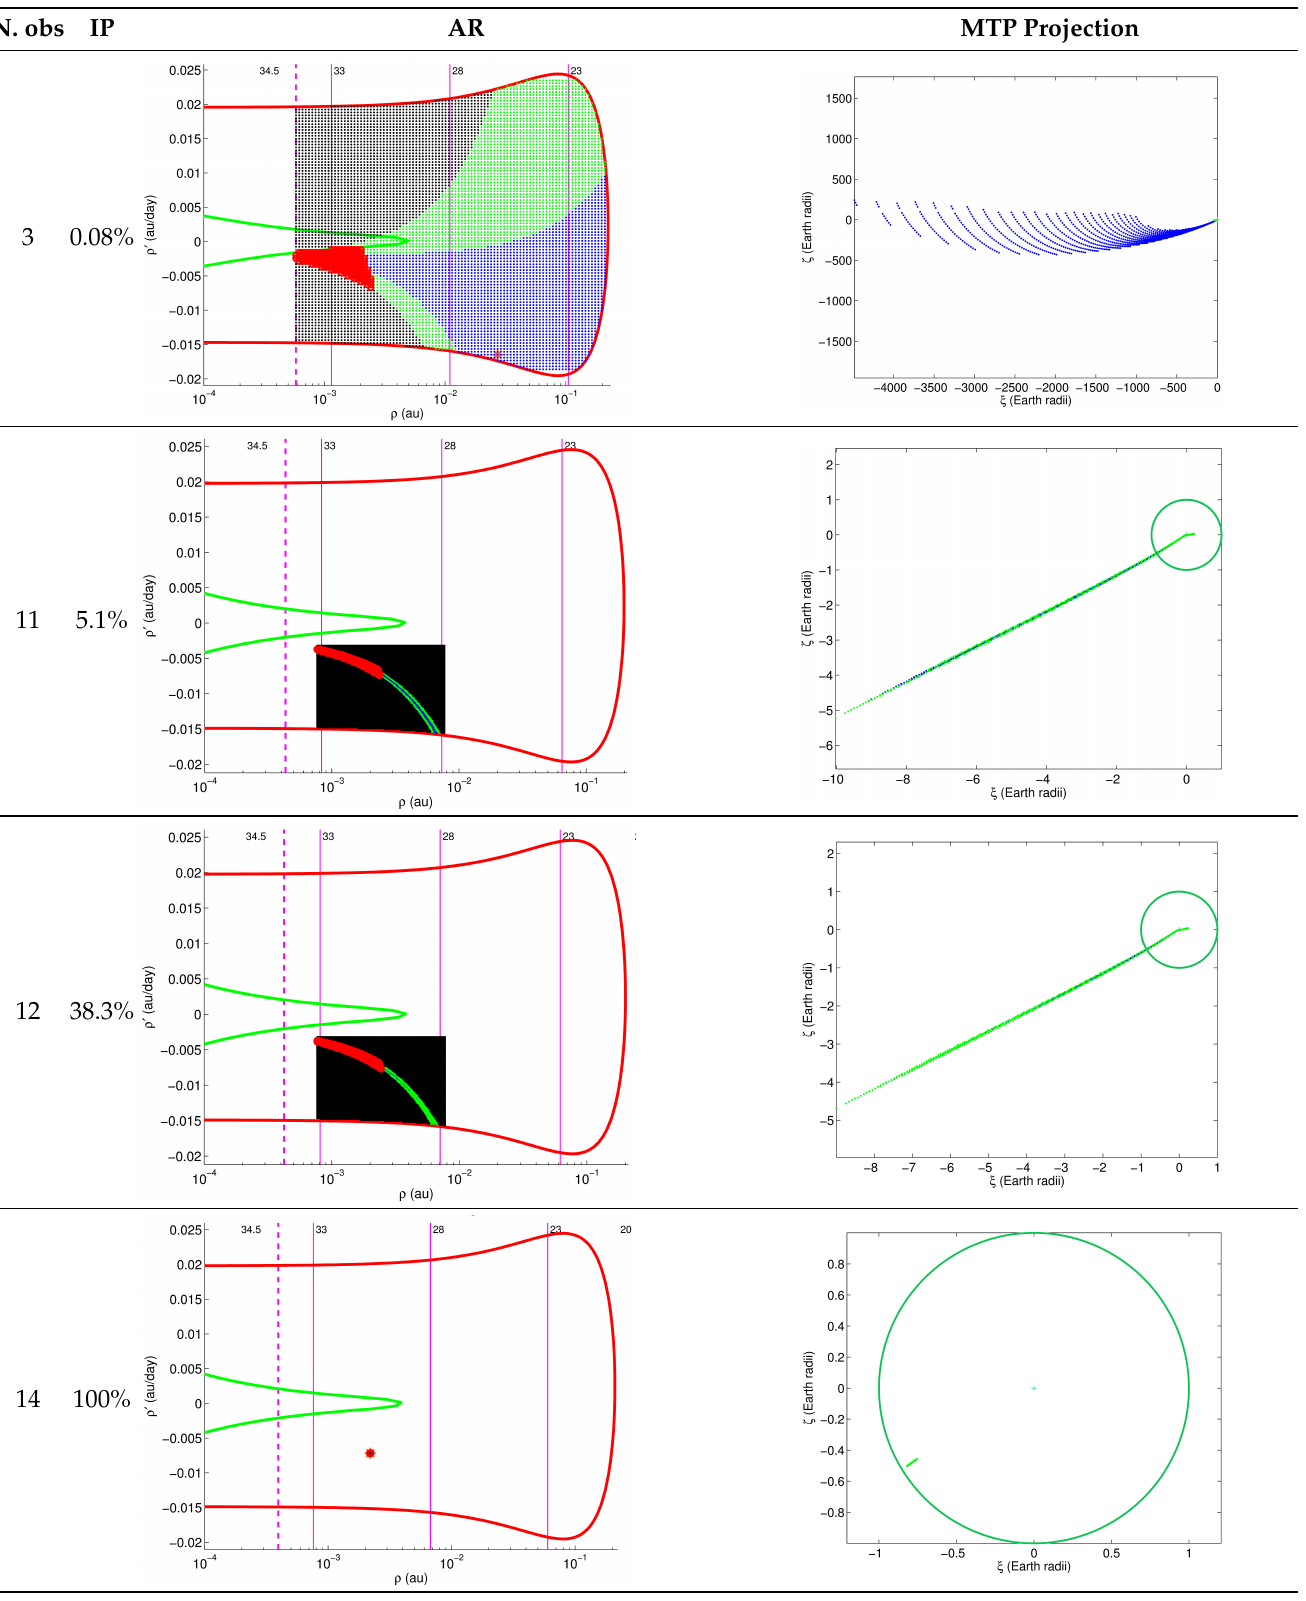
Table 1. Evolution of the IP, AR and MTP projection for each tracklet obtained for 2018LA. Figures from [60]. N. obs